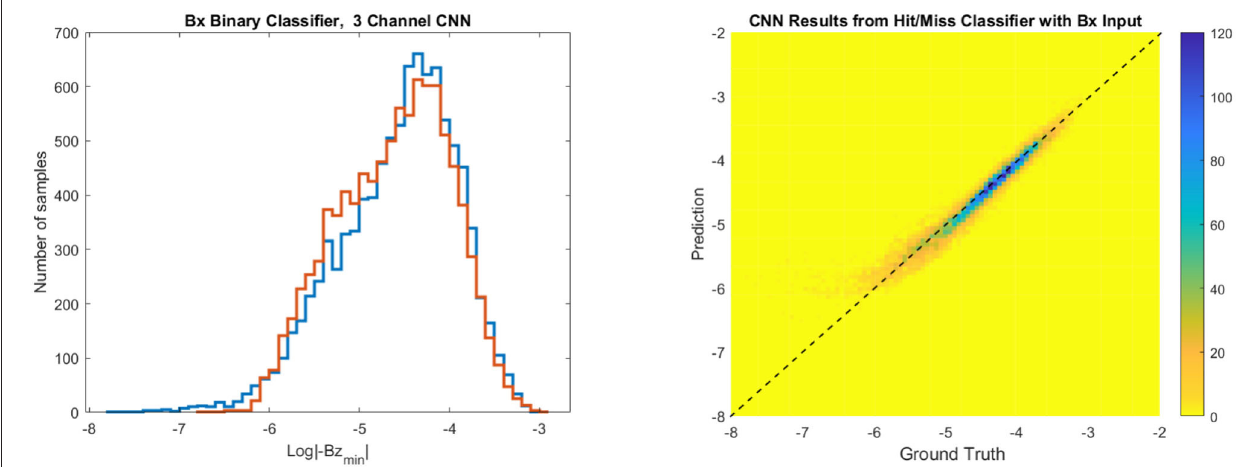
FIGURE 12 | A histogram (blue is ground truth) and scatter plot, of ground truth vs. predictions of CNN 1 , when using the B x component of magnetic field at the Sun as input for the binary classifier FNN 1 and then feeding the events labeled as “storms” into the 9 layer CNN 1 to predict the value of max {− B z } . The color bar indicates the number of samples. The axes in the scatter plot are that of log 10 { max {− B z }} , and in both plots the units of max {− B z } are G.